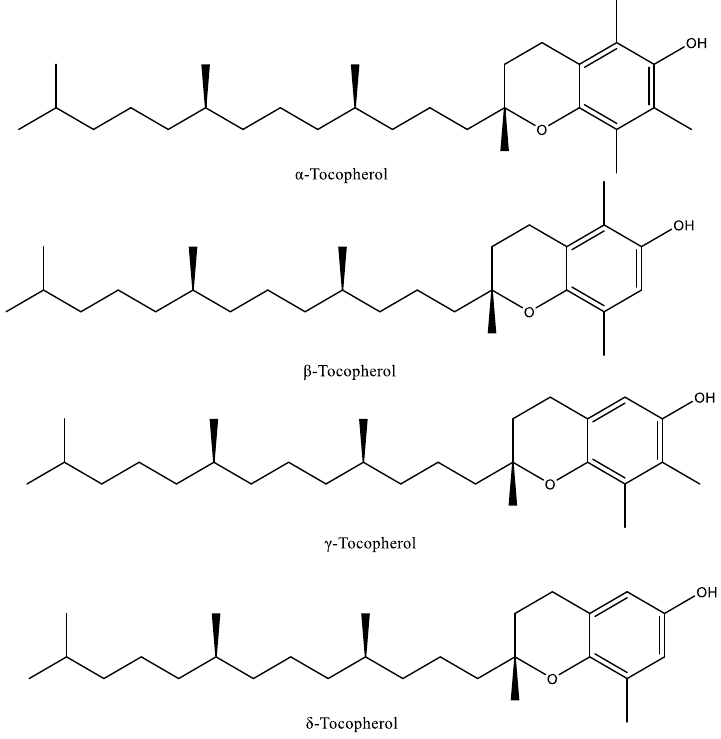
Figure 6. The four isomers of tocopherol: α -, β -, γ -, and δ -tocopherol.